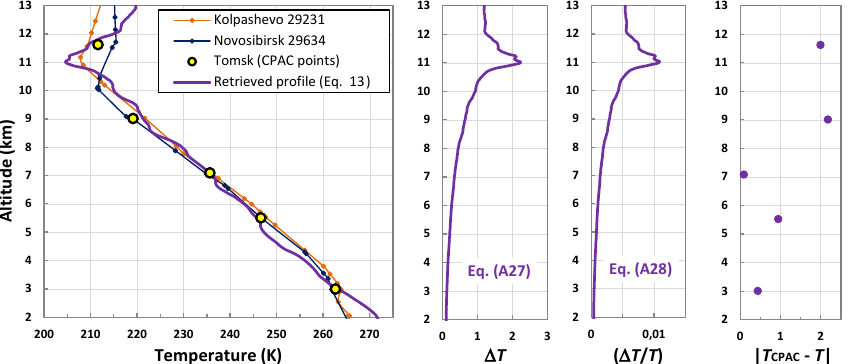
Figure 6. (1 April 2015) Temperature profile retrieved using the temperature retrieval function (Eq. 13) derived from the standard cali- bration function suggested by Behrendt and Reichardt (2000). The uncertainties (cid:49) T and ( (cid:49) T / T ) are calculated by Eqs. (A27) and (A28),